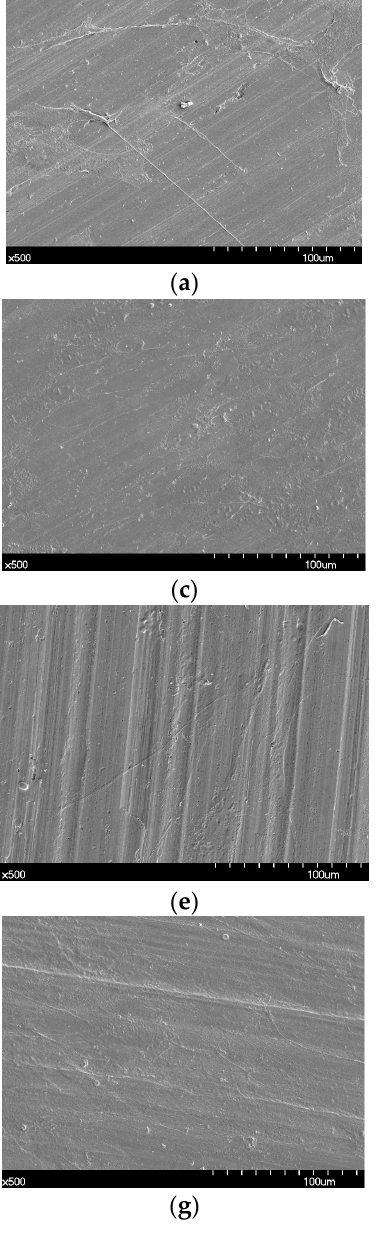
Figure 5. Scanning electron microscopy images showing human adipose derived stem cells (hADSCs) that were seeded on the Ni-Cr disk and the Co-Cr disk. ( a ) Cells seeded on a Ni-Cr disk, original magnification 500×, ( b ) original magnification 2000×, ( c ) cells seeded on a Co-Cr (casting), original magnification 500×, ( d ) original magnification 2000×, ( e ) cells seeded on a Co-Cr (milling) disk, original magnification 500×, ( f ) original magnification 2000×, ( g ) cells seeded on a Co-Cr (3D) disk, original magnification 500×, ( h ) original magnification 2000×.